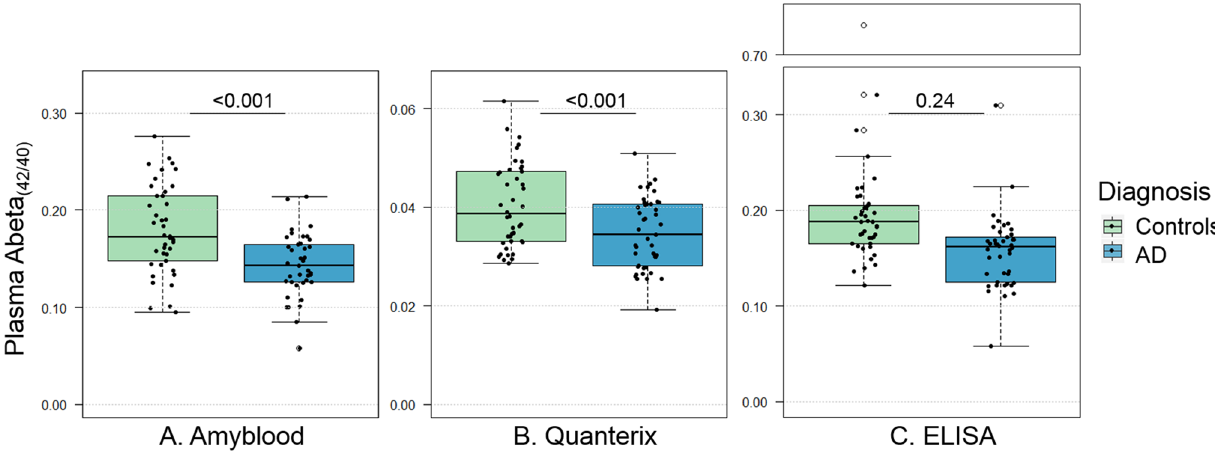
Figure 4. The plasma Abeta 42/40 ratio measured with three different immunoassays. Plasma Abeta 42/40 ratio’s measured in CSF Abeta 1-42 negative controls and CSF Abeta 1-42 positive AD groups. ( A ) Abeta 1-42/1–40 measured with the Amyblood assays. ( B ) Abeta x-42/x-40 measured with the Quanterix triplex. ( C ) Abeta 1-42/1–40 measured with the Euro-immun ELISA assays. P-values are corrected for sample batch, sample storage time, age, and